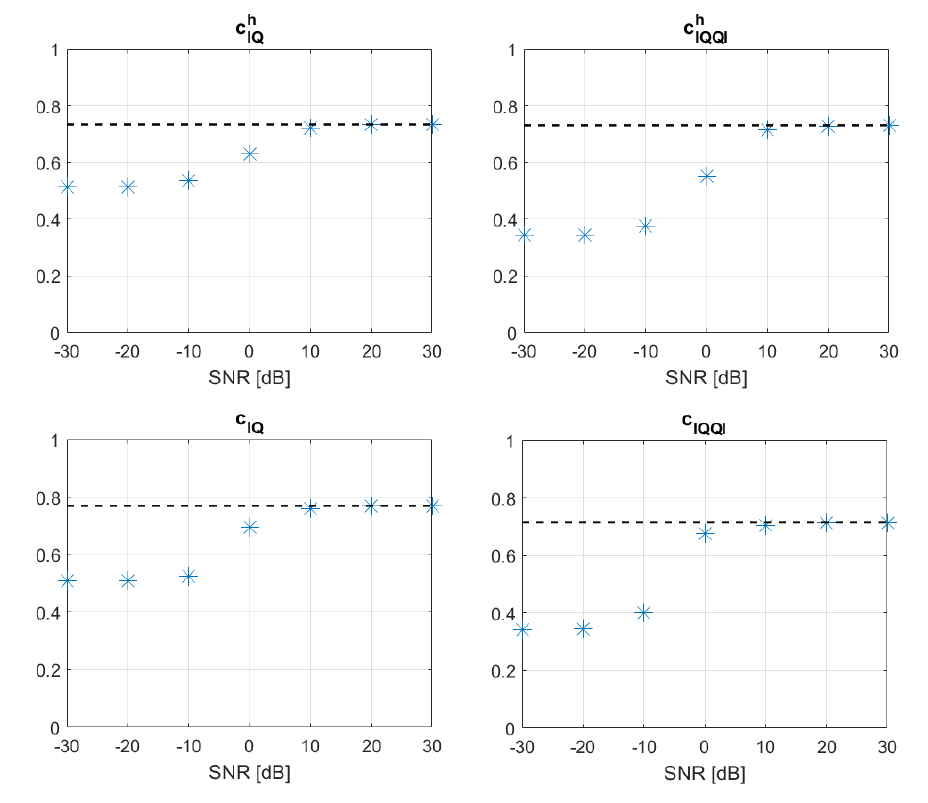
Figure 5. Correlation coefficients calculated on the basis of a signal received at a distance of 1035 m, disturbed by simulated AWGN; the dashed line represents the coefficient value obtained in the